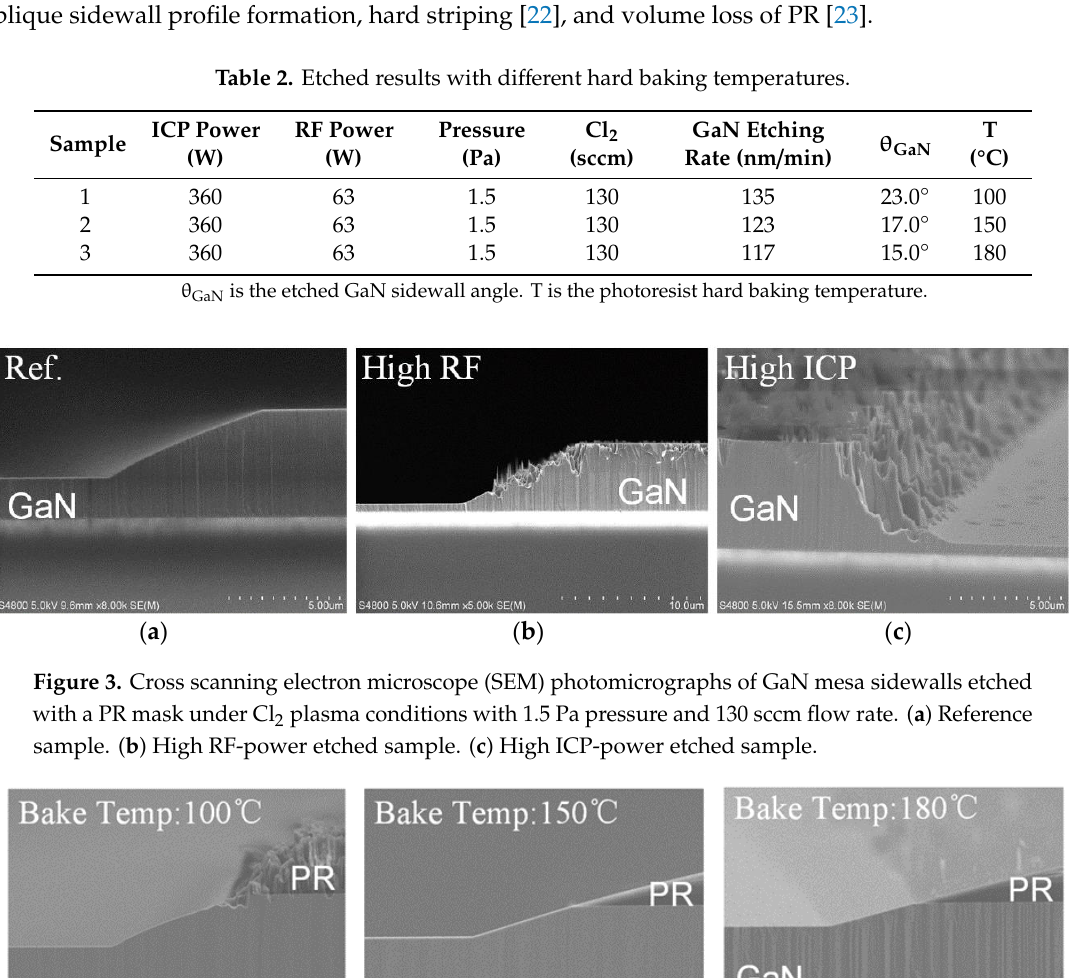
Figure 4. Cross SEM sidewall profiles of photoresist (AZ4620)-masked GaN samples after etching with different hard baking temperatures. (a) 100 °C; (b) 150 °C; (c) 180 °C .